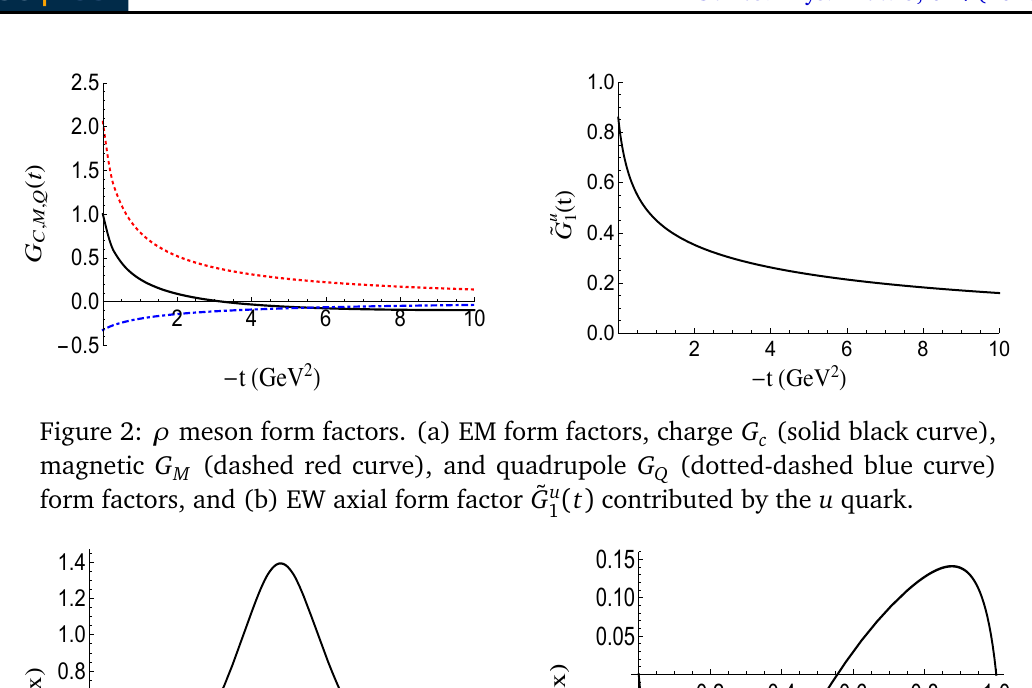
( x ) contributed by the u , and (b) b u 1 1